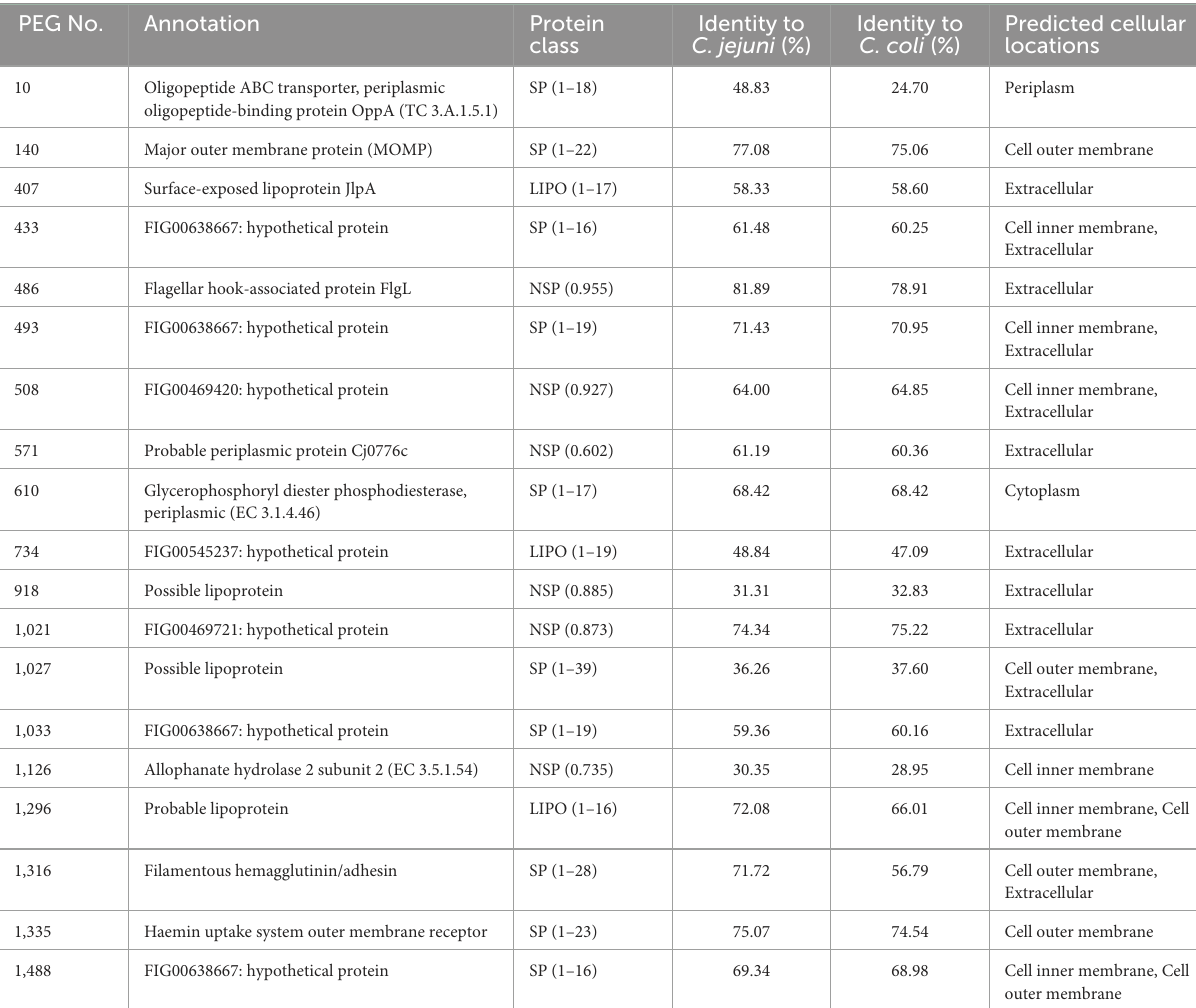
TABLE 1 PEGs shortlisted for cloning and expression using bioinformatics tools. PEG No.